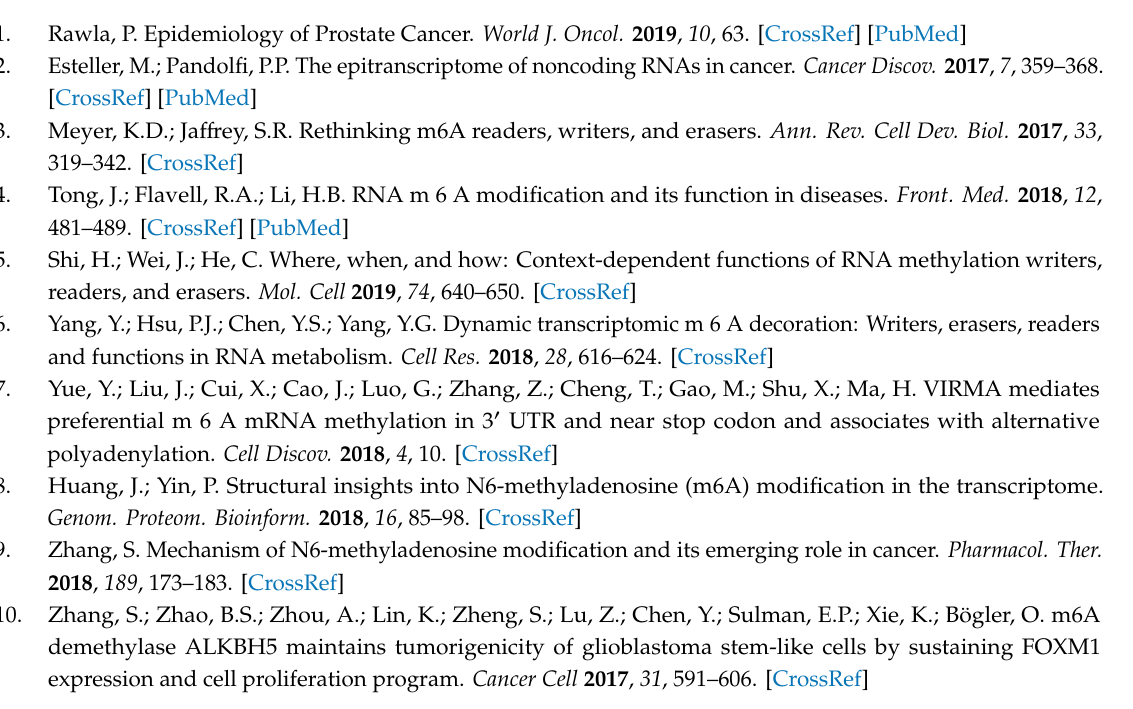
Table S1: RT 2 lncRNA PCR Array Human Cancer Pathway Finder data, Table S2: Clinical and pathological data of the fresh-frozen tissues included in this study, Table S3: Primary antibodies used in Western blot, immunofluorescence and immunohistochemistry, Table S4: Specific primer sequences. Full western blot images are provided in Supplementary information